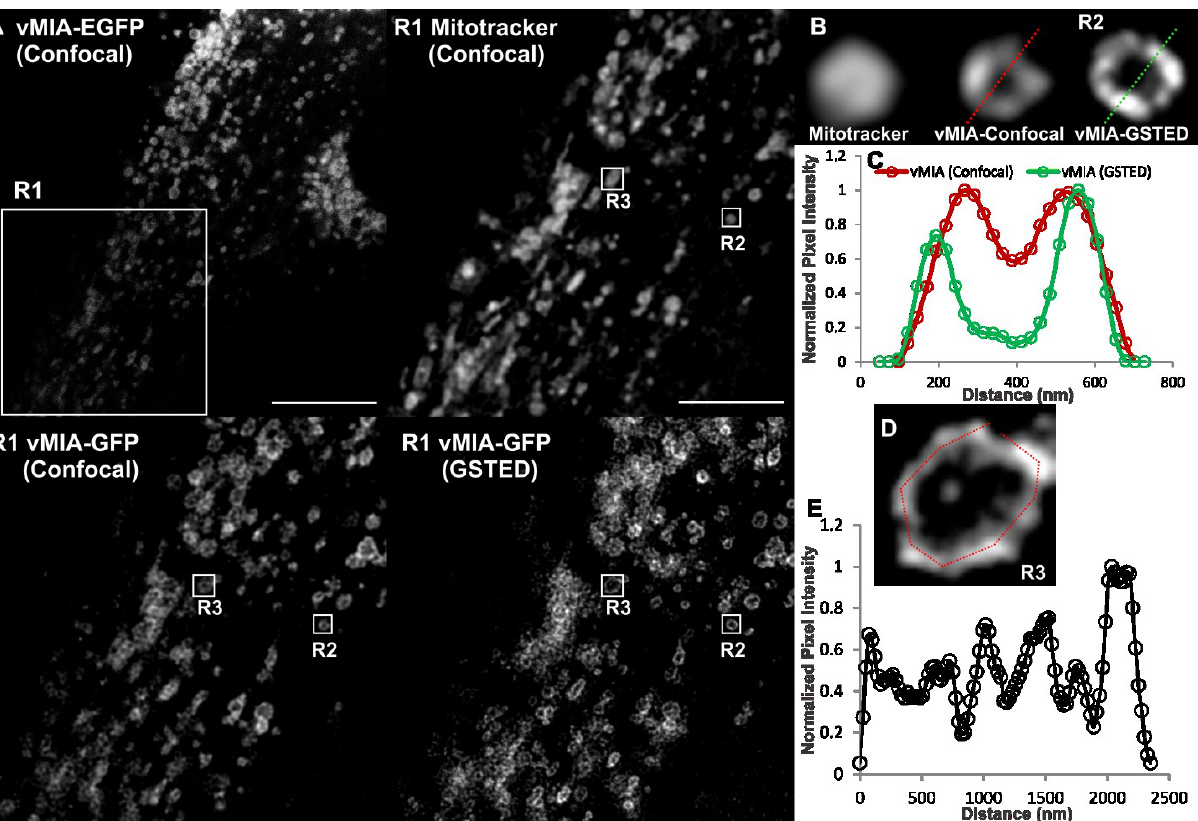
Figure 6. GSTED microscopy of vMIA-EGFP in human astrocytoma cells. U373-Tet-ON cells expressing the tetracycline controlled transactivator (tTA) [51] were lipofected with the tetracycline responsive element (TRE-Tight) promoter driving expression of vMIA-EGFP. At 24 hours post transfection, cells were treated with doxycycline (Dox) for 60 minutes, labeled with MitoTracker Red (0.5 µM) and imaged live using Confocal (vMIA-GFP and MitoTracker Red) and GSTED (vMIA-GFP). ( A ) An optical slice showing deconvolved confocal image of a cell expressing vMIA-EGFP and a zoom of the region corresponding to the boxed region (R1) are shown in the left panel. Right panel presents the zoom of the R1 region showing the deconvolved GSTED (bottom) and deconvolved confocal MitoTracker (top) channels. ( B ) Zoomed confocal images of the mitochondrion in the region R2 showing the various channels acquired — Confocal images of MitoTracker Red and vMIA-EGFP as well as GSTED image of vMIA-EGFP. ( C ) Normalized intensity profile along the dotted line shown on the confocal and GSTED images of R2 demonstrate the improved resolution of vMIA localization by GSTED imaging as compared to confocal imaging. ( D ) Zoom of region R3 showing GSTED image of vMIA ( E ) Intensity profile of the pixels marked by the red line in panel ( D ). For higher resolution images, see Supplemental Figure